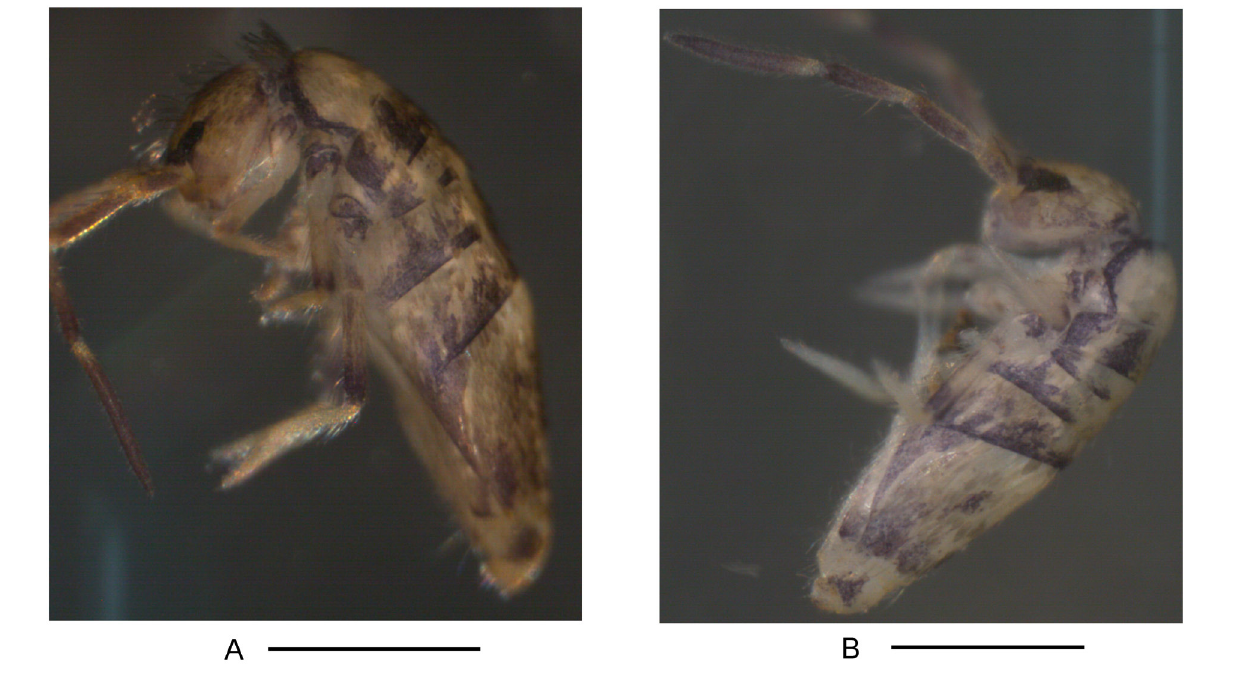
Fig. 5. Willowsia christianseni sp. nov. A–B . Habitus. Scale bars: 500